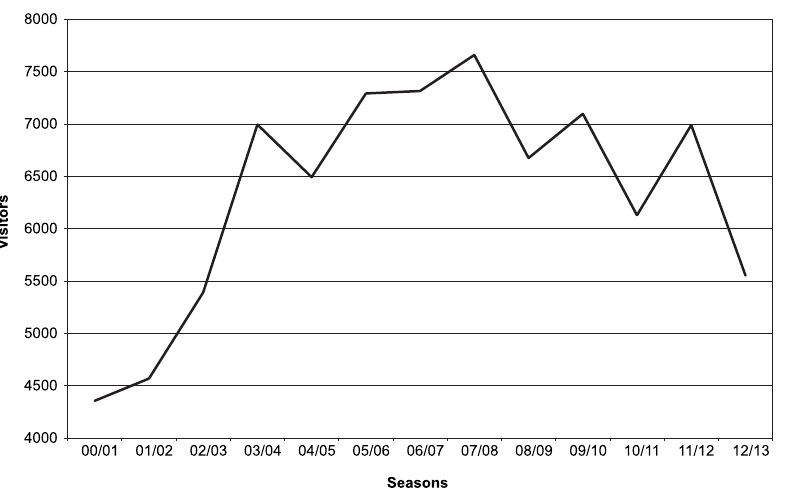
seasons.Fig. 4. The number of tourists visiting Aconcagua region during thirteen consecutive tourist (Fig. 5). Apart from absolute data, the percentage